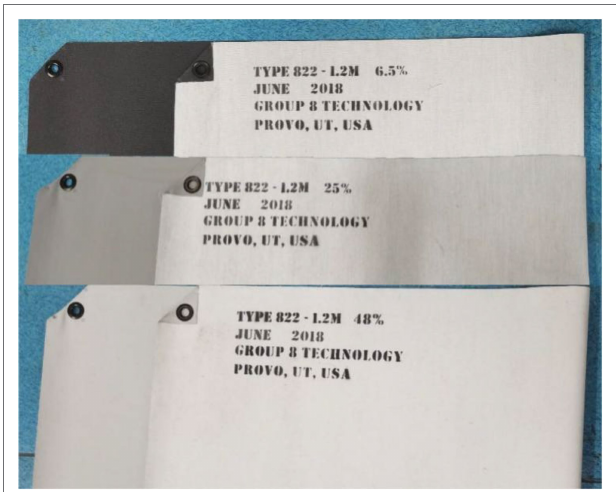
FIGURE 14 | Three diffusion